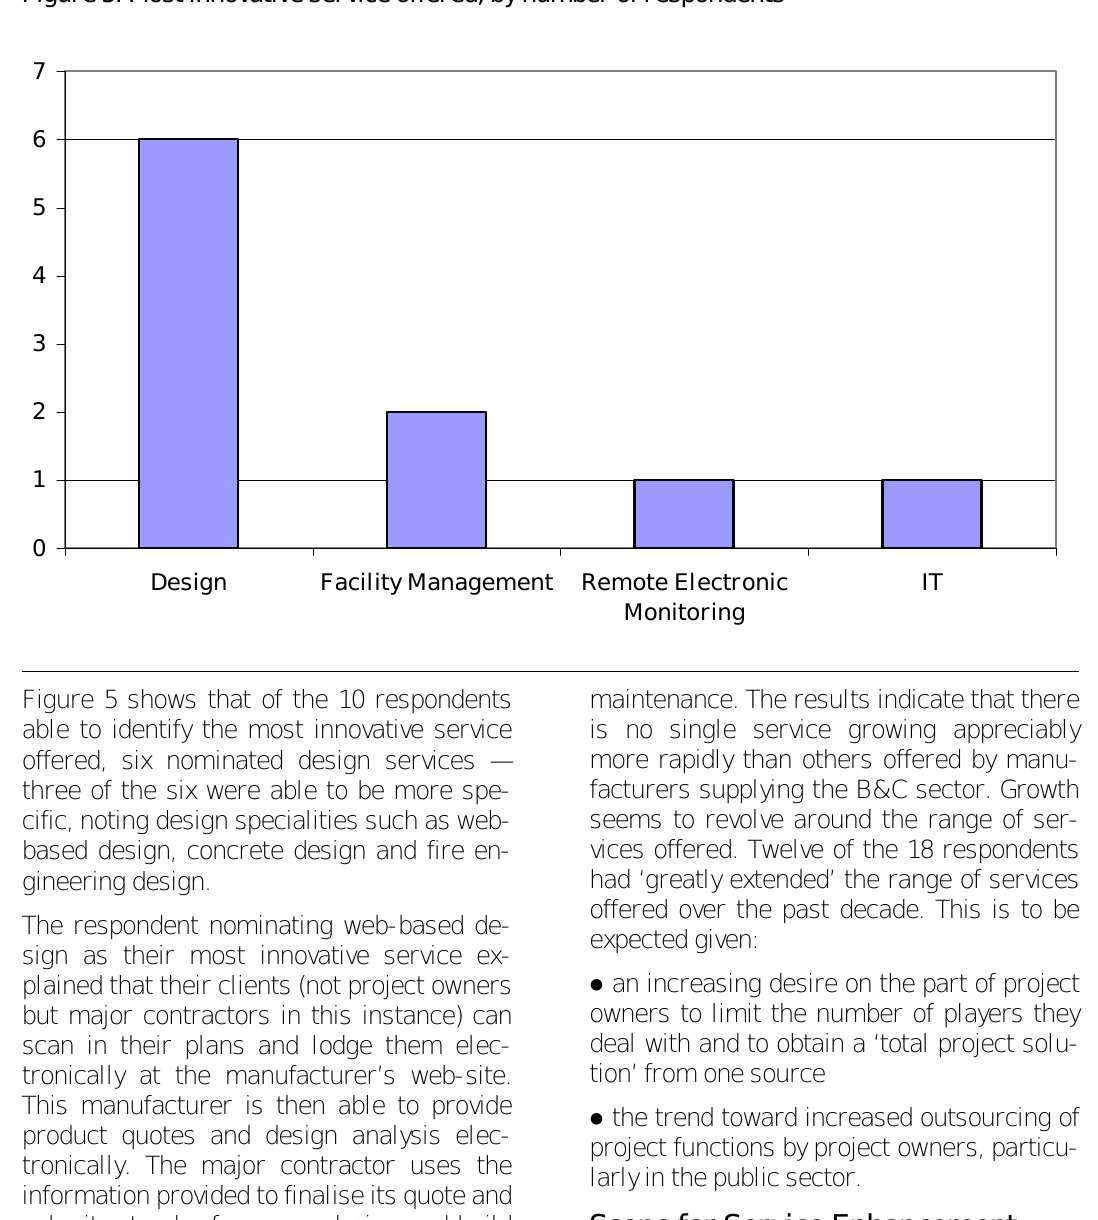
Figure 5: Most innovative service offered, by number of